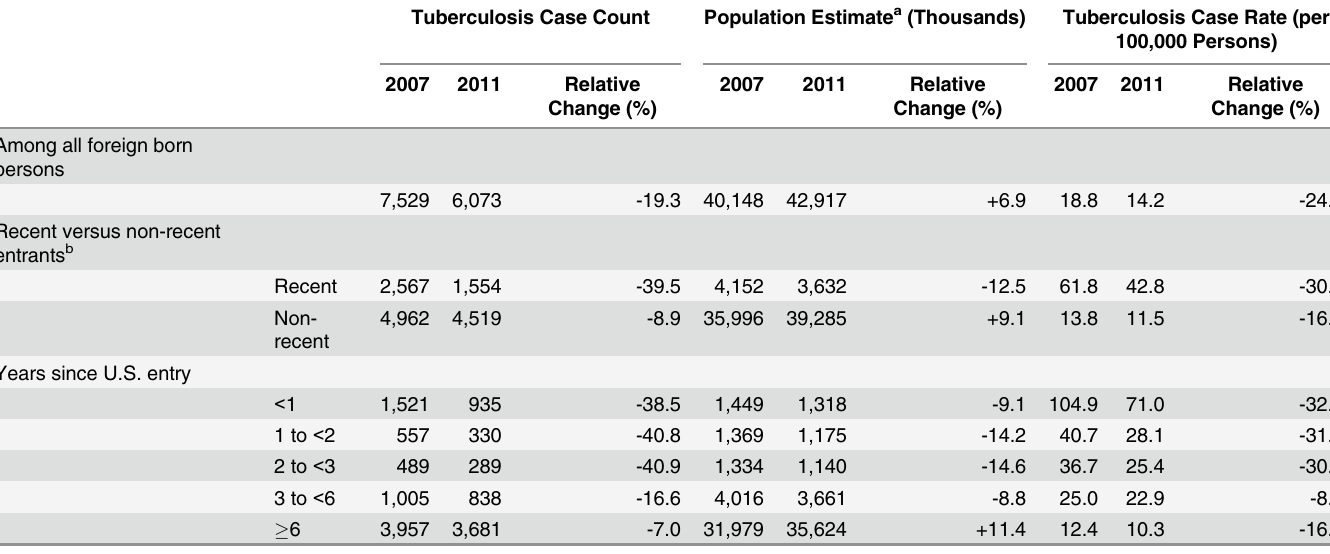
Table 1. Changes in tuberculosis case counts, population estimates, and tuberculosis case rates among foreign-born persons in the United States, 2007 and 2011.